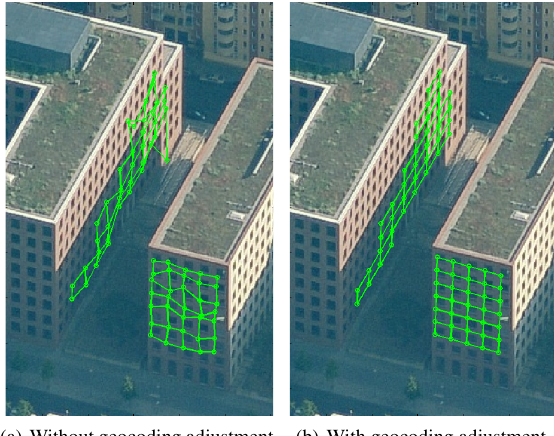
Figure 11: Improvement of two facades at site Park Kolonnaden,